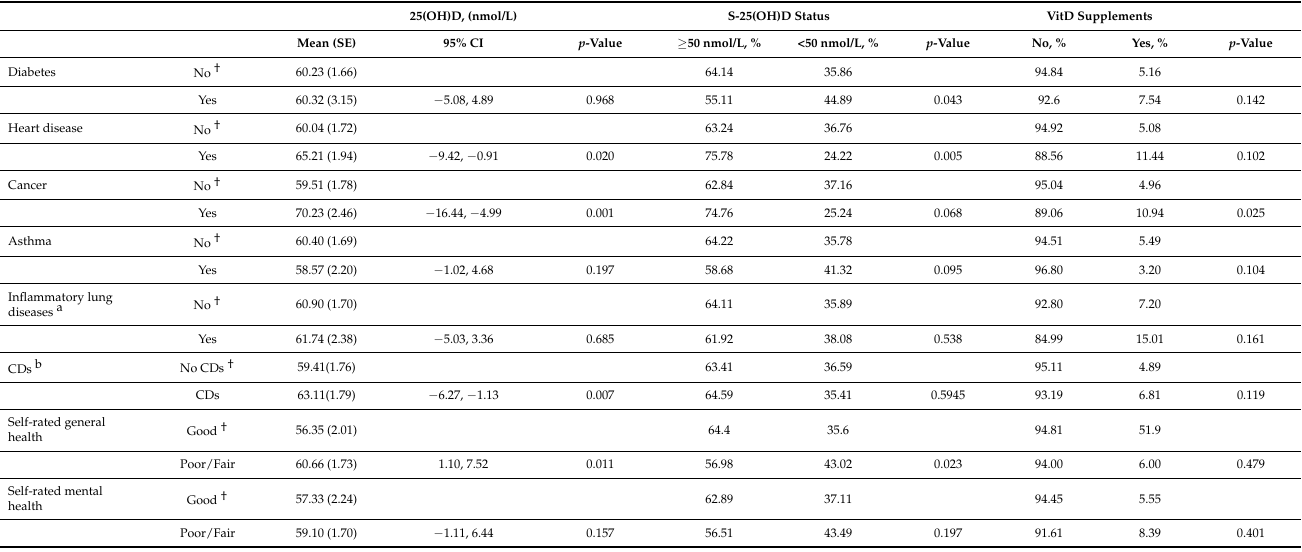
Table A5. Weighted mean and status of 25(OH)D for each chronic disease and the use of vitD